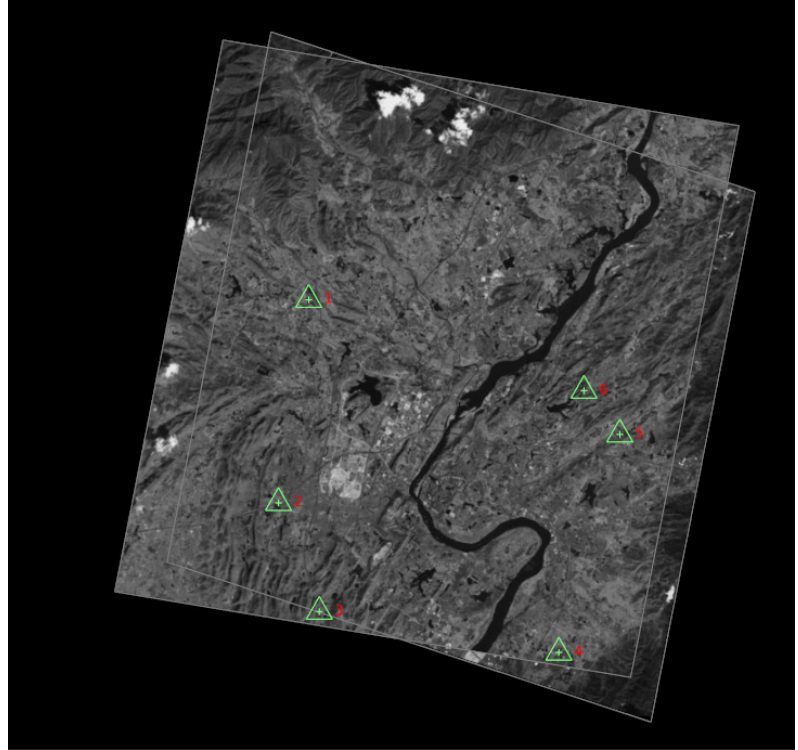
Figure 15. Ground control points selected for the Yingde stereo image pair.